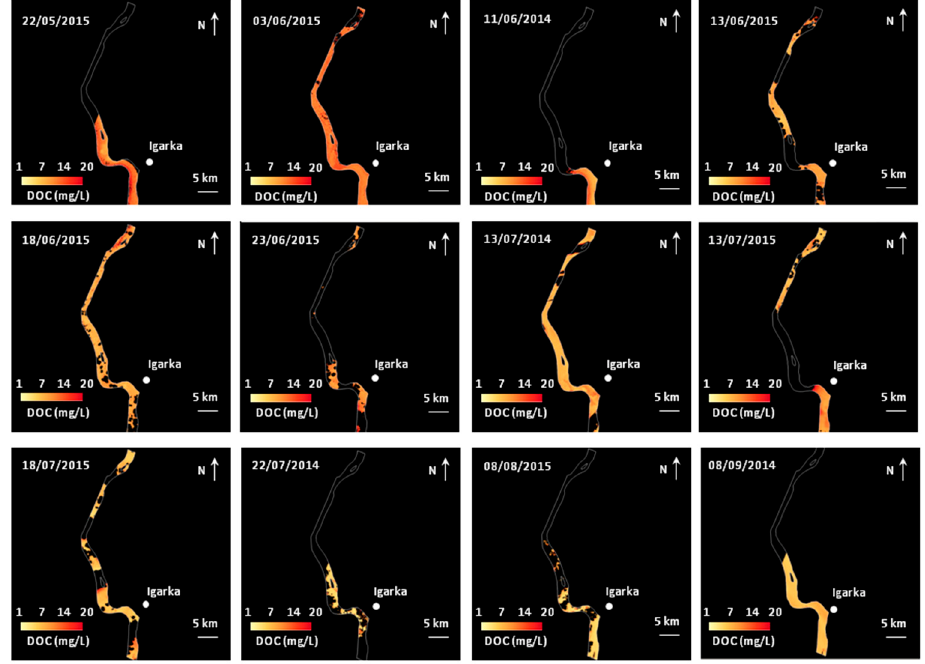
Figure 7. Mapped DOC during a theoretical open-water season. The best CDOM retrieval algorithm (model 6) was applied on a broader extent (available maximum extent on SPOT5 scenes) to produce estimates of DOC. The maps were produced by a cross-validation method (leave-one-out) and reorganized following a seasonal chronological order, e.g., from 22 May to 8 September (by merging the two years).